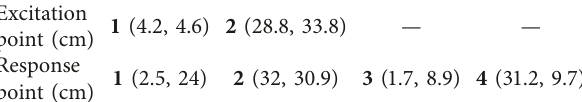
Figure 9: Sensor layout of excitation points and acceleration response points. Table 10: Coordinates of excitation points and response points.